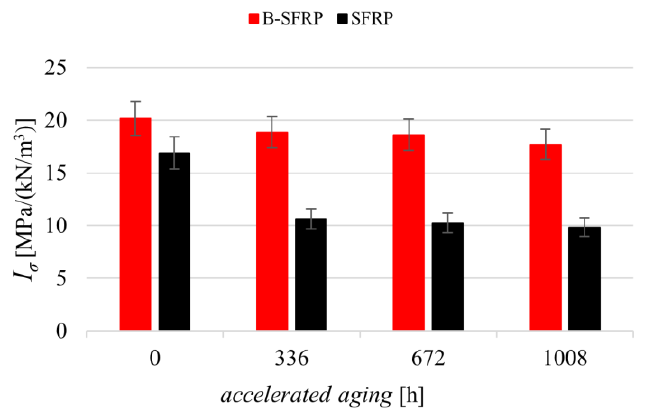
Figure 10. Specific strength of the SFRP and B-SFRP before and after the progressive aging.